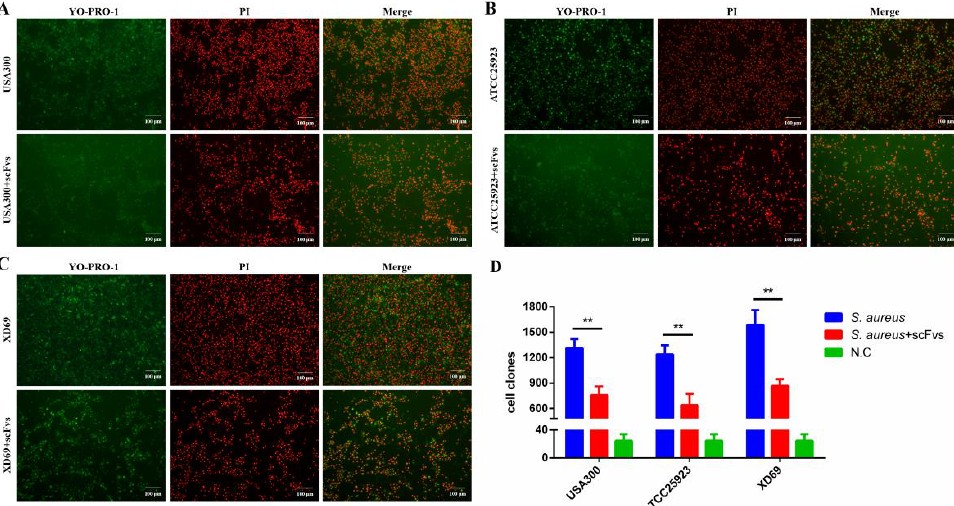
Figure 5. Apoptosis and necrosis of MAC-T cells infected by S. aureus or plus with mixture of scFvs. MAC-T cells treated with USA300 ( A ), XD69 ( B ) and ATCC25923 ( C ) strains or plus with mixture of scFvs. Continuously increasing green fluorescence alone indicates apoptotic cells, while simultaneous red and green fluorescence indicates dead. ( D ) Cell clones of apoptotic and necrotic MAC-T cells infected by three S. aureus strains. Data represent mean results ± SD ( n = 3) (** p <